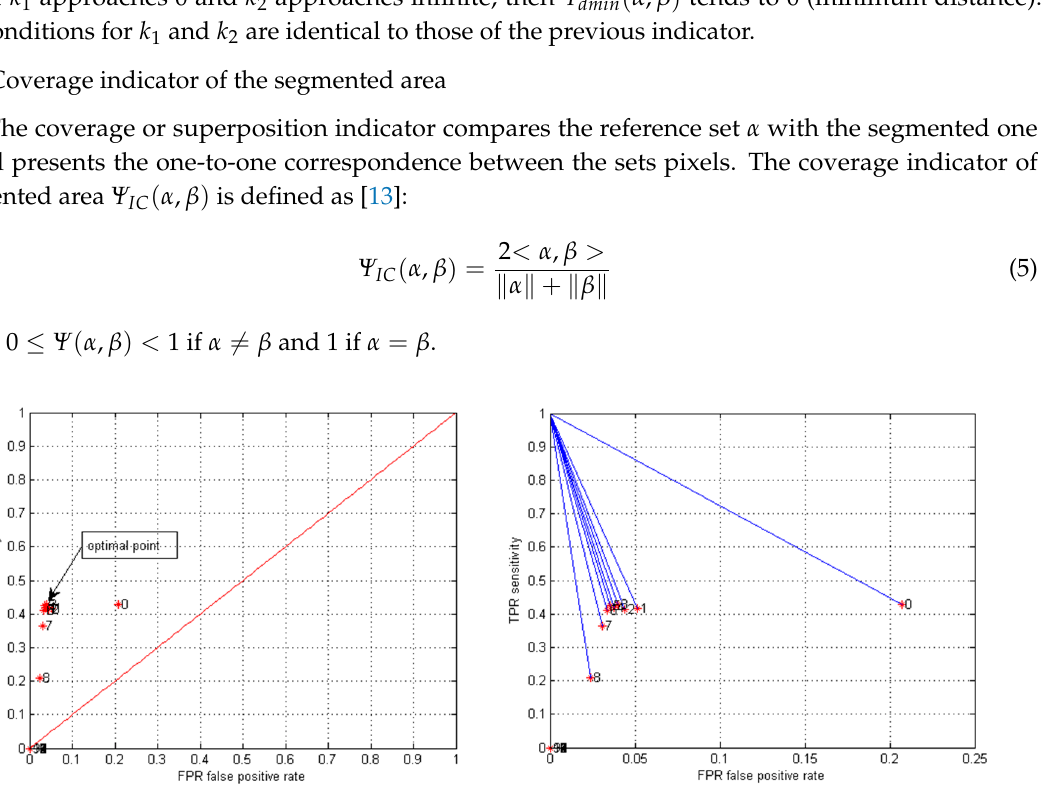
Figure 2. ( A ) A receiver operating characteristic (ROC) curve obtained from tuning the Canny edge detector with Figure 1A. The index of sensitivity was obtained from the ROC curve. It represents a relationship between the true positive rate (TPR) when it tends to 1 and the false positive rate (FPR) when it tends to 0. ( B ) Minimum distance between the perfect segmentation point (0,1) and the point (FPR, TPR).